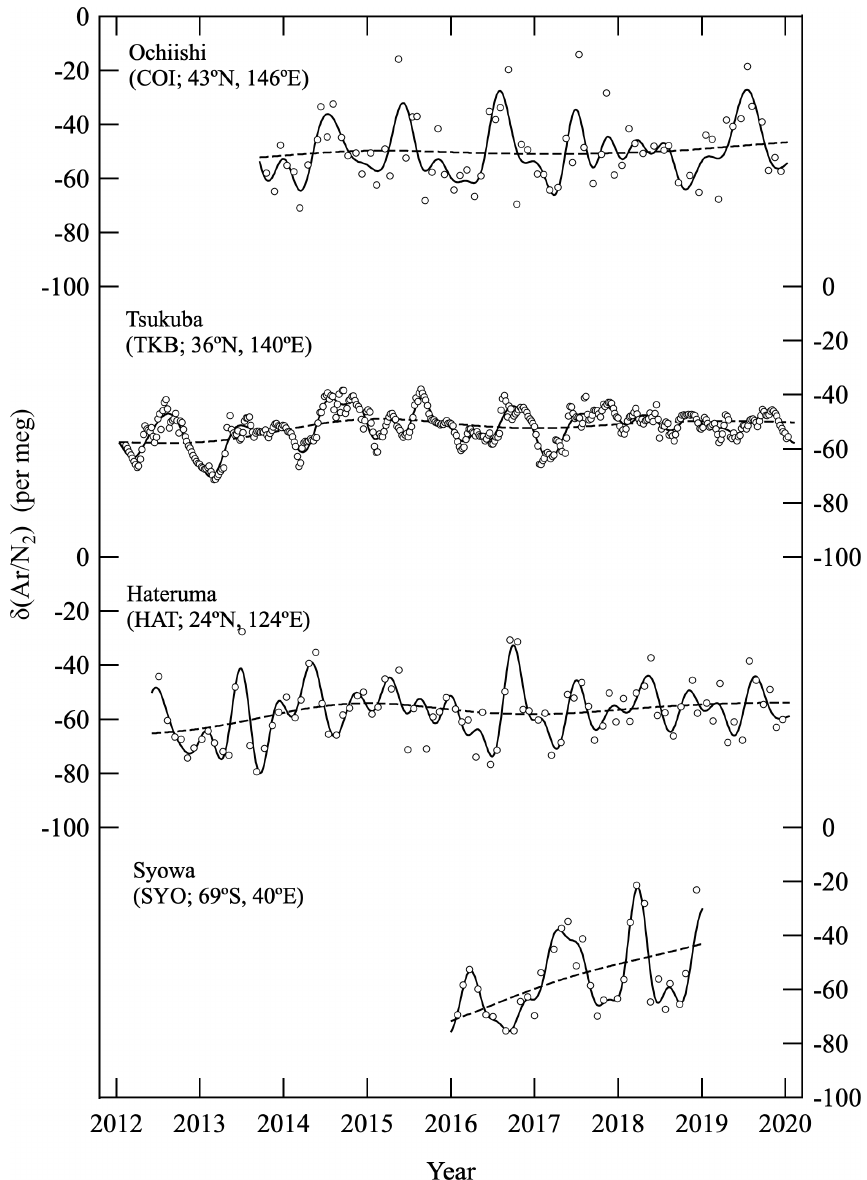
Figure 2. Temporal variations of δ (Ar / N 2 ) at Ochiishi (COI), Tsukuba (TKB), and Hateruma (HAT), Japan, and Syowa (SYO), Antarctica. Observed values are shown by open circles. Best-fit curves to the data (solid lines) and interannual variations (dashed lines) are also